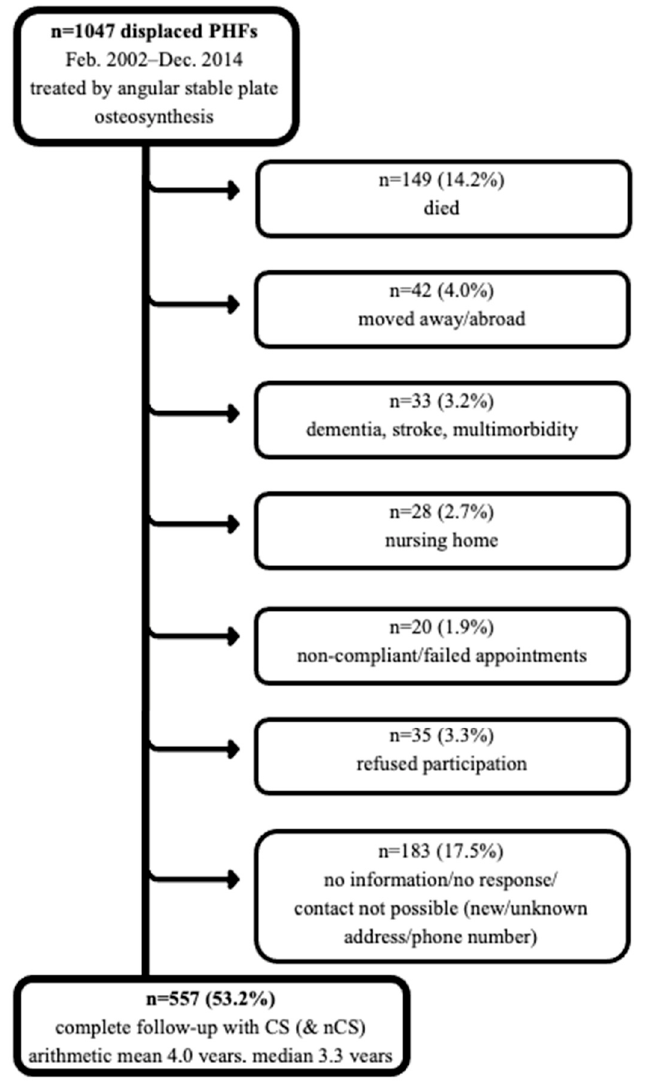
Figure 1. Flow chart of patients included at 4 years of follow-up.